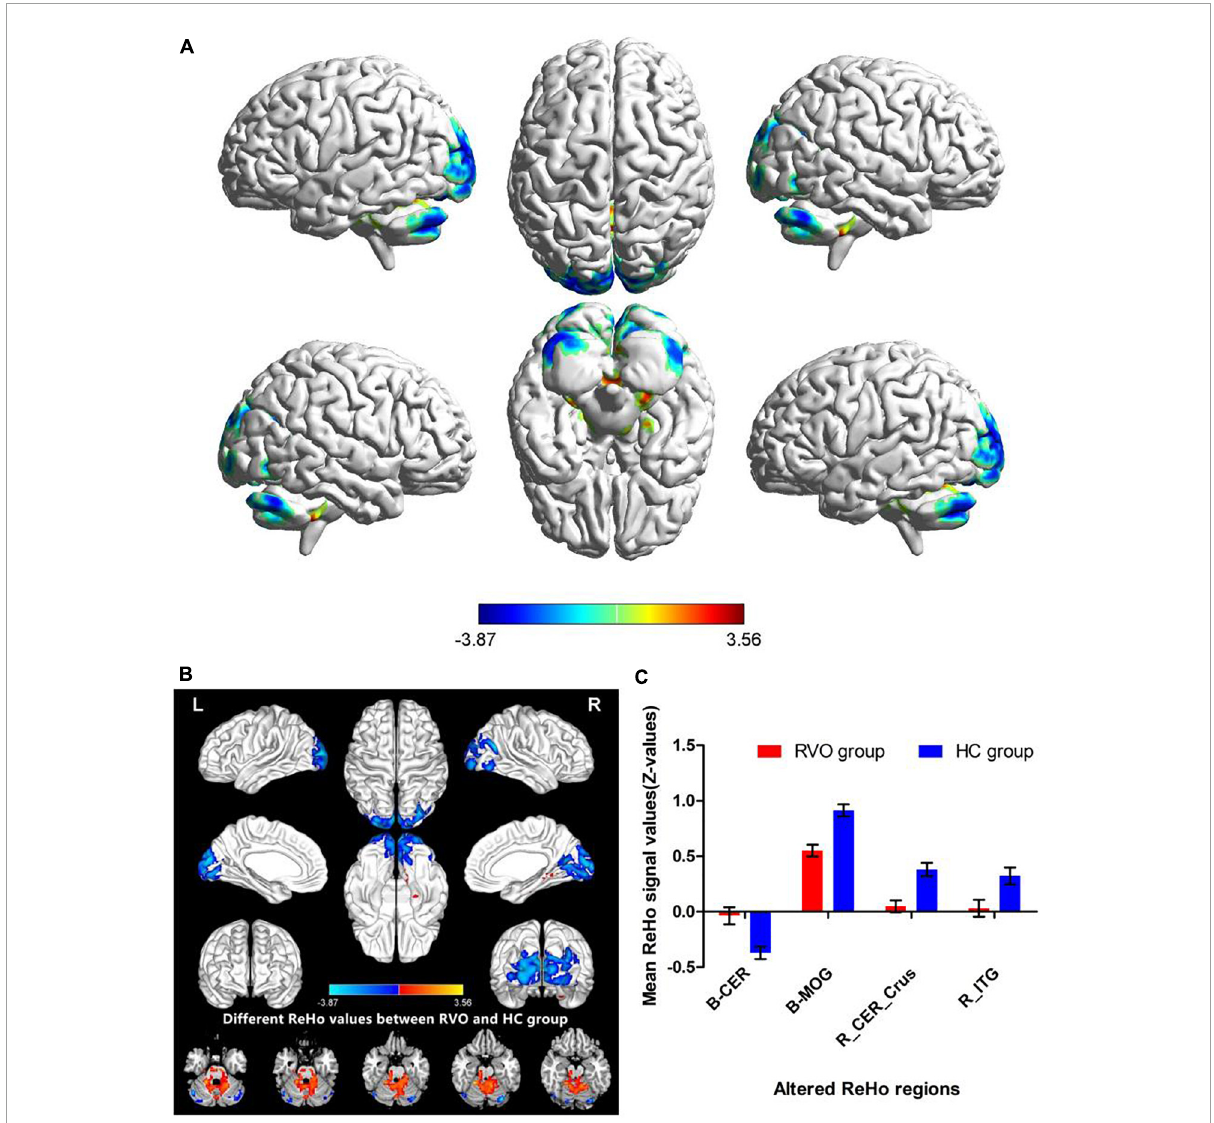
FIGURE3 Different ReHo values between RVO group and HC group. (A) The 3D picture of different ReHo values between two groups. (B) The 2D picture of different ReHo values between two groups. (C) The mean values of altered ReHo values were shown with a histogram.